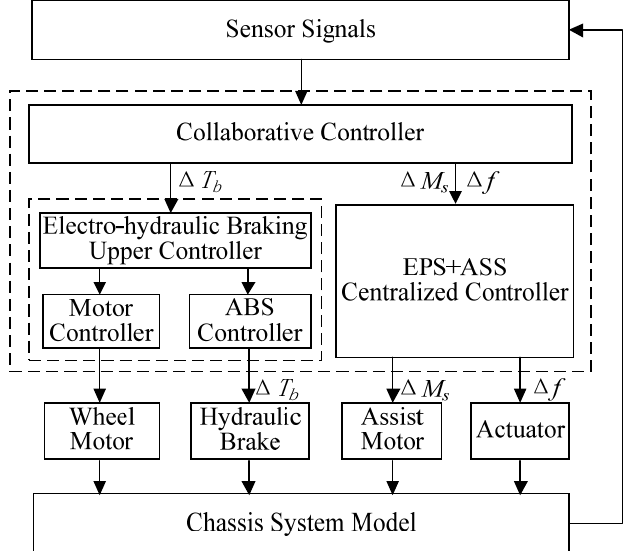
Figure 3. Electric vehicle chassis system collaborative control